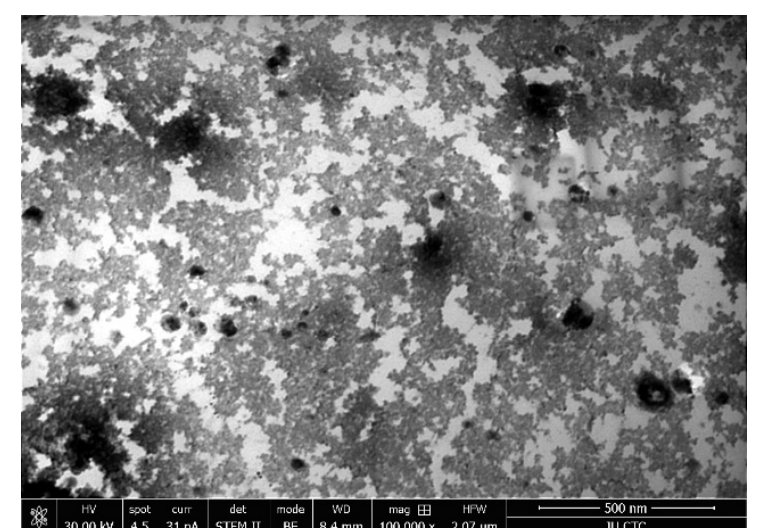
Figure 2. ( a ) TEM image of the NiFe 2 O 4 -NP and ( b ) particle size distribution with a Gaussian fit. Fit y = y 0 + A with R 2 = 0.67, where y 0 = − 2.677 ± 18.510, x c = 2.105 ± 0.213, w = 2.712 ± 4.025, and A = 32.186 ± 10.782.